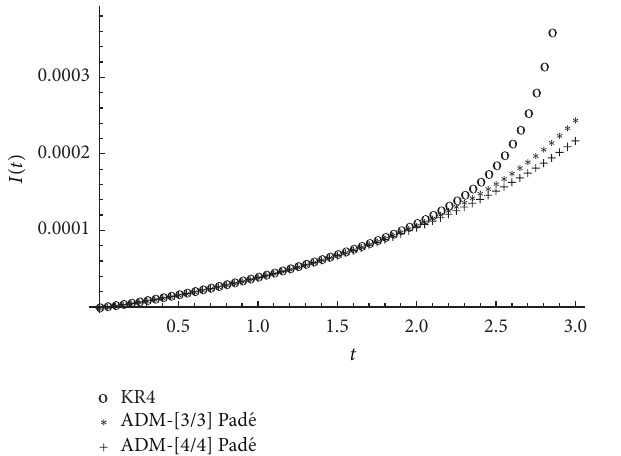
Figure 8: Curves of KR4, ADM-[3/3] Pad´e approximation, and ADM-LPL for 𝐼(𝑡) .